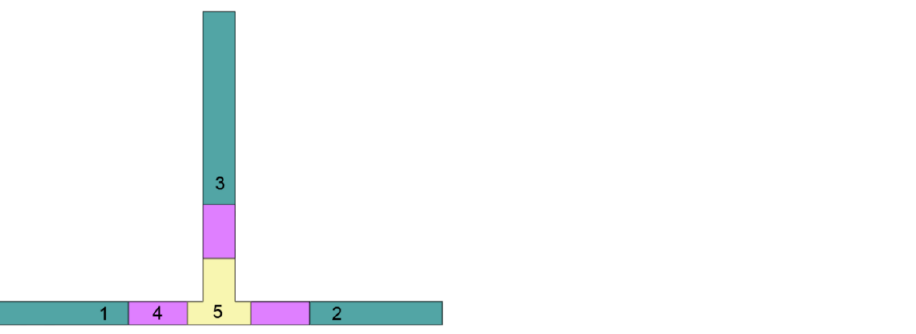
Figure 3. Reynolds numbers at the ( a ) inlets and ( b ) outlet.